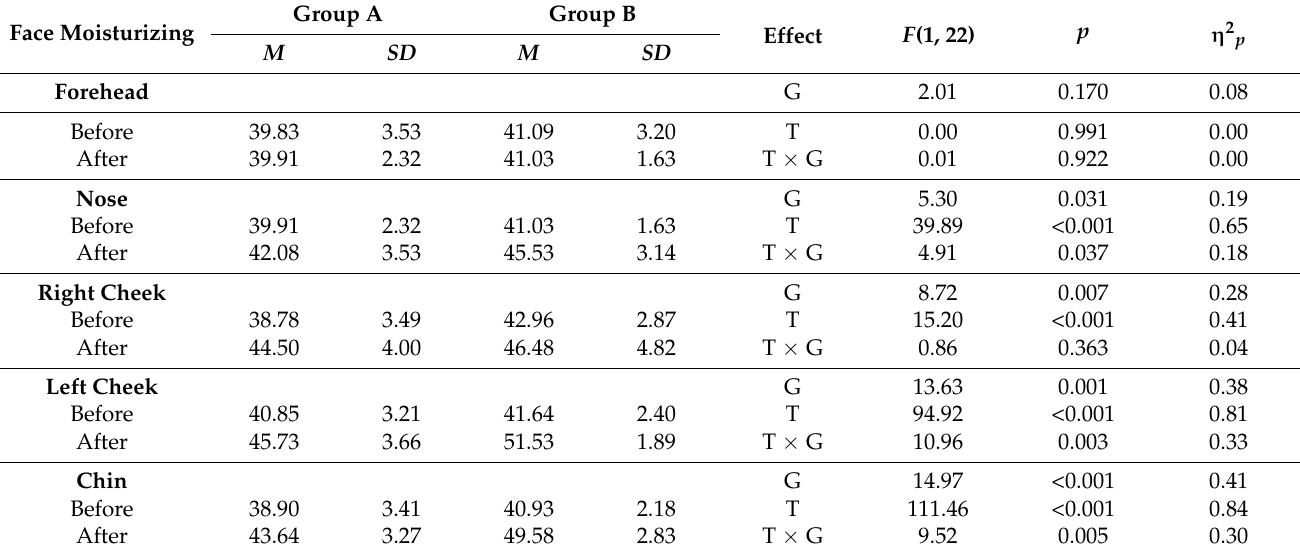
Table 2. Repeated measures of one-way ANOVA for face moisturizing in groups A and B, before and after treatment, using Corneometer CM825 (g/m 2